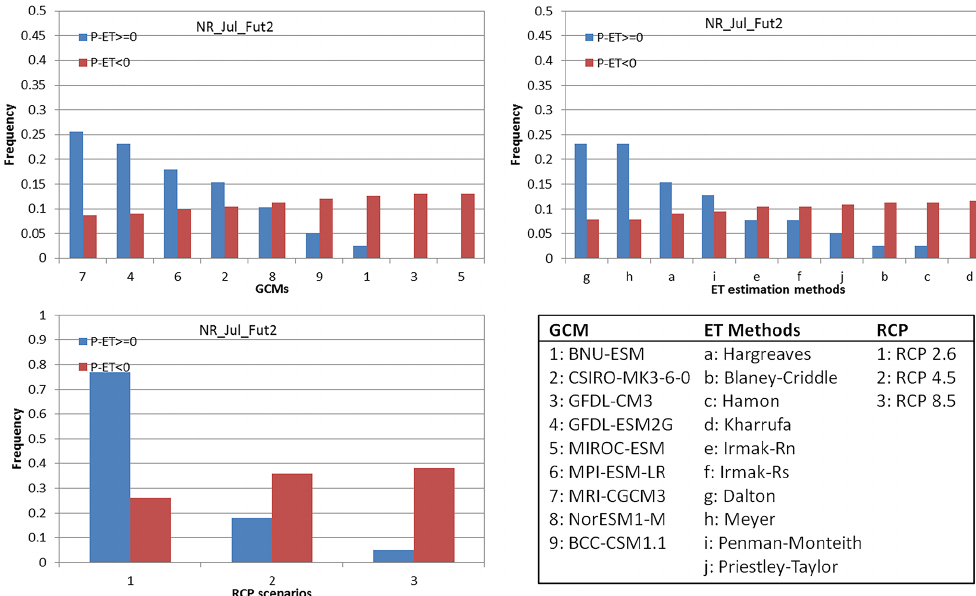
Figure 10. Histograms for projected future period 2 wet conditions and dry conditions in the Northern Rockies and Plains US by GCMs, the ET 0 method, and RCP trajectory for the month of